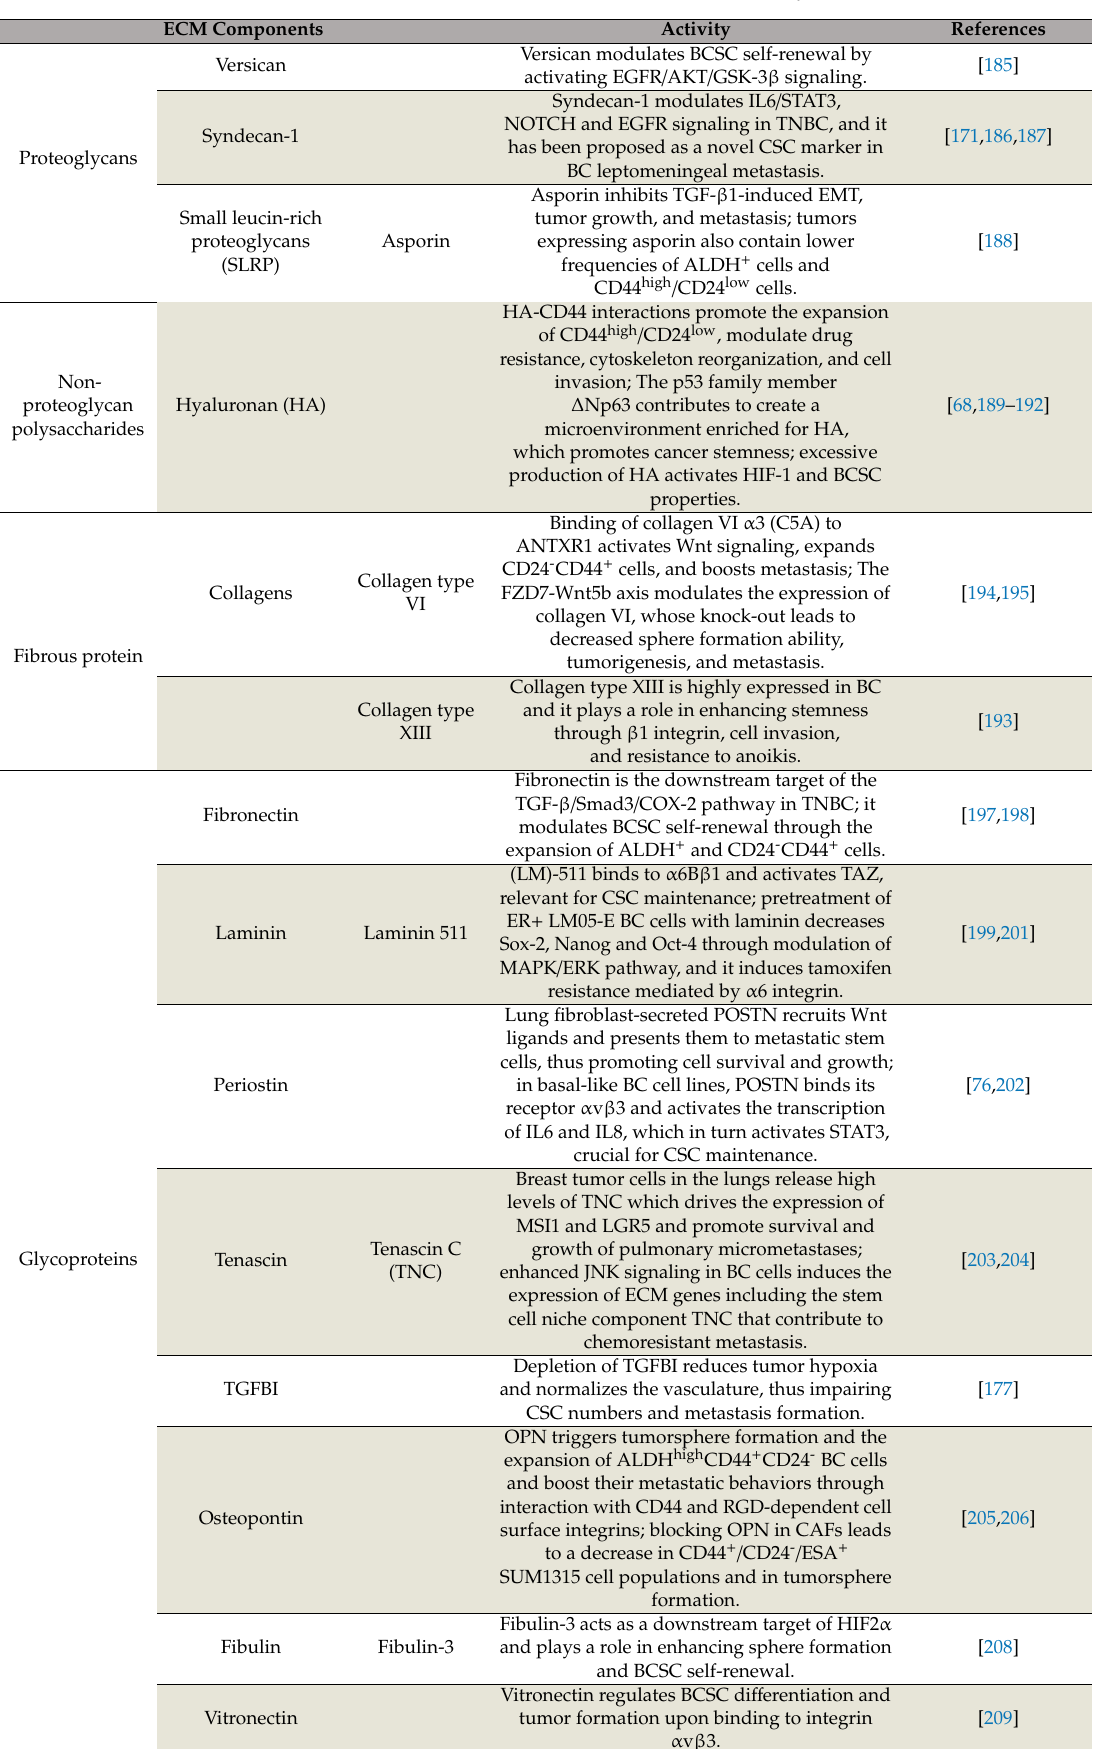
Table 1. Extracellular matrix molecules with BCSC modulatory